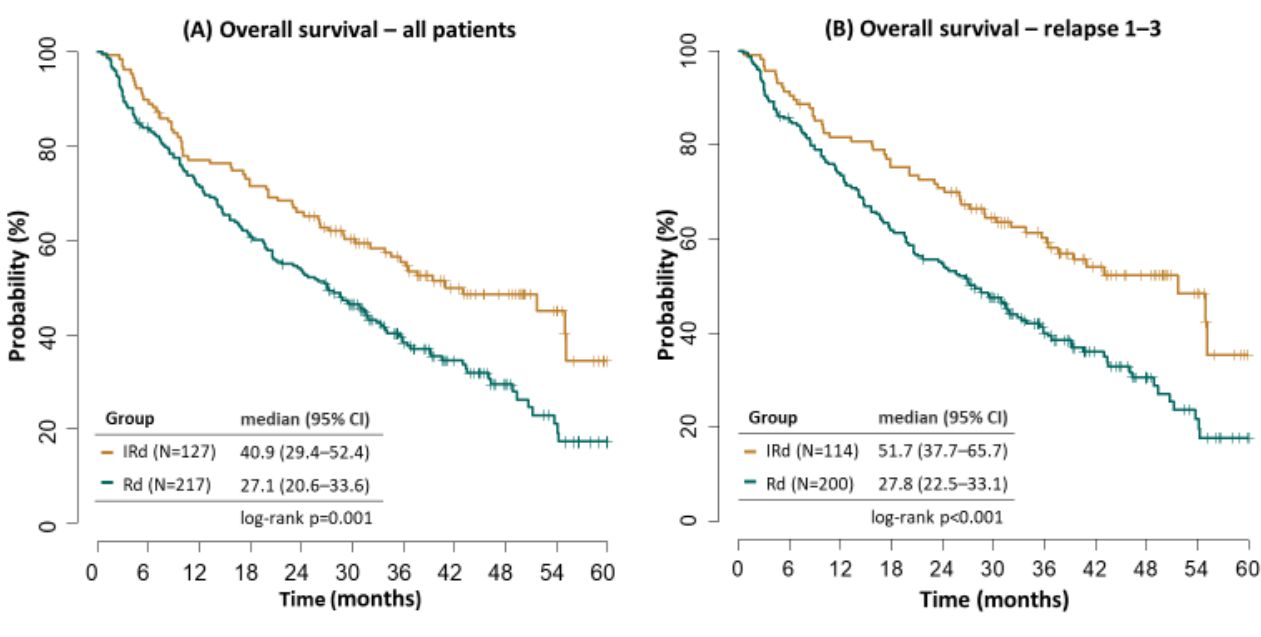
Figure 3. Overall Figure 3. Overall survival.